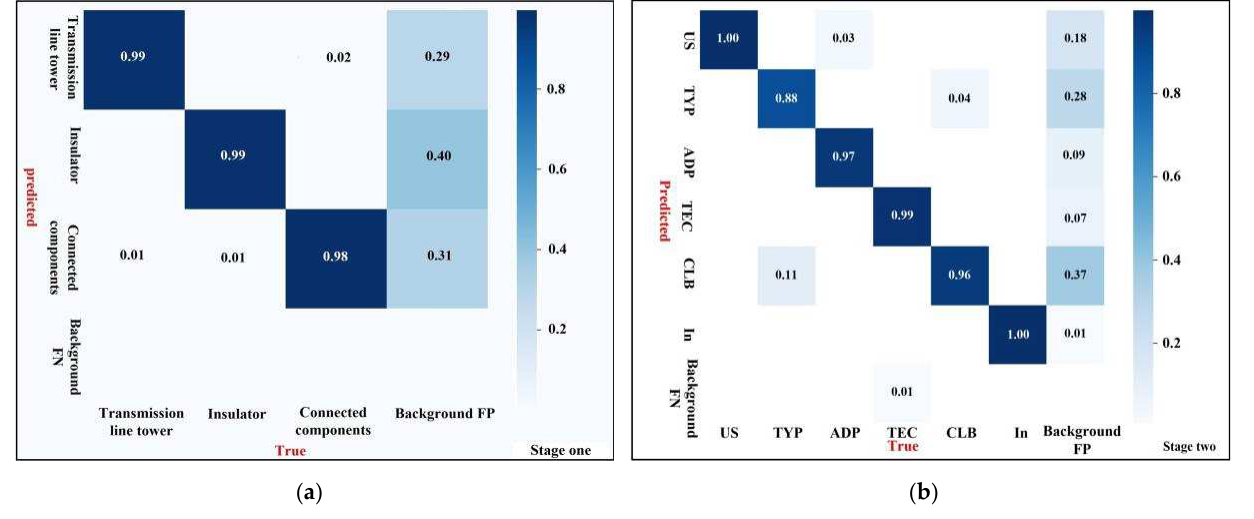
Figure 15. Two-stage test sample confusion matrix. ( a ) The first stage test sample confusion matrix. ( b ) The second stage test sample confusion matrix.